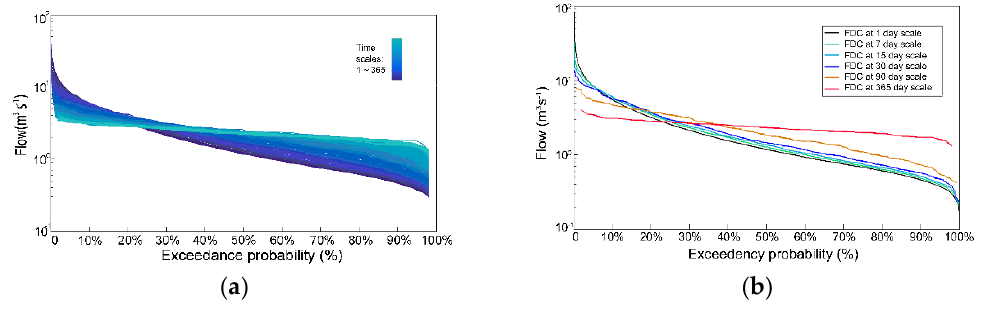
Figure 2. Empirical flow duration curve (FDC) variations with time scales for a randomly selected catchment. ( a ) Time scales from 1 day to 365 days. ( b ) Time scales at 1, 7, 15, 30, 90, and 365 days.